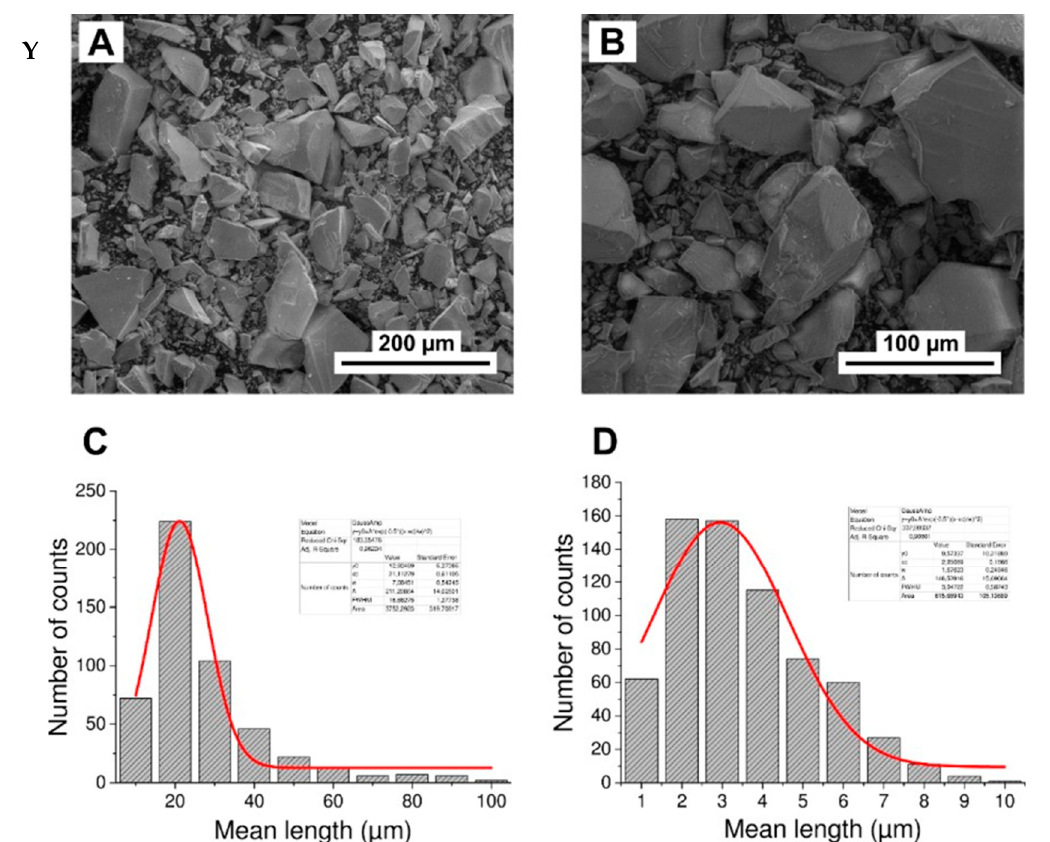
Figure A3. The FTIR spectra for GAp, YAp and HAp (nanoXIM HAp403) powders ( a ). The regions of stretching vibration of hydroxyl groups (OH ν s ), of carbonate ions (CO 3 ν s ), and of hydroxyl group libration bands (OH-lib) are marked. Asymmetric stretch ( ν 3 ) regions of the FTIR spectrum fitted with Gaussian distributions corresponding to the peaks and shoulders evident in envelope are shown for HAp ( b ) and GAp ( c ). X: Powder X-diffraction lines identified by Miller indices (hkl) for lattice planes. Y: SEM micrographs of GAp powder ( A , B ). LVSED (low-vacuum secondary electrons detector): 15.0 kV, 8.7 mm; magn.: 500×, 1000×. The histograms of the mean size of powder grains with the fits of Gauss functions for GAp powder in the range of 10–100 µm ( C ) and below 10 µm ( D ). Chemical composition and structural data for GAp and YAp